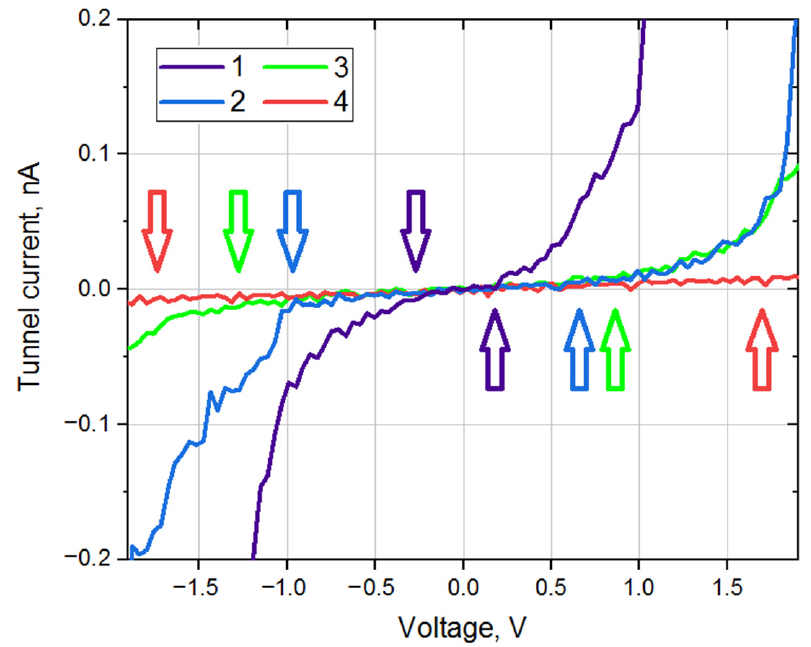
Figure 2. Types of local volt-ampere characteristic (VAC) curves, corresponding to various copper oxides. The edges of zero-current sections for various curves are marked with colored arrows.